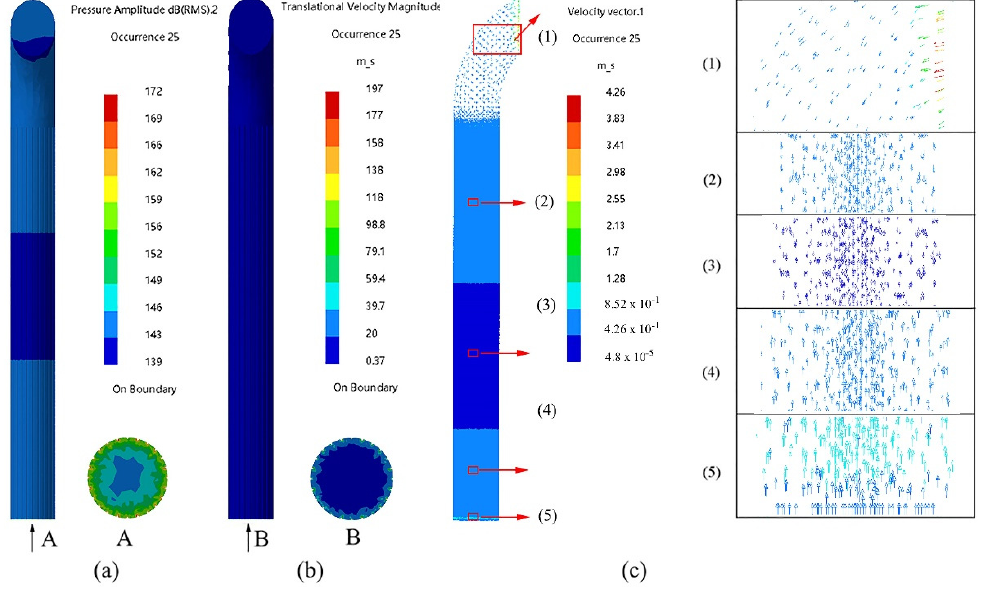
Figure 19. Optimized bionic exhaust tailpipe: ( a ) sound pressure level amplitude nephogram, ( b ) velocity amplitude nephogram, and ( c ) velocity vector diagram.